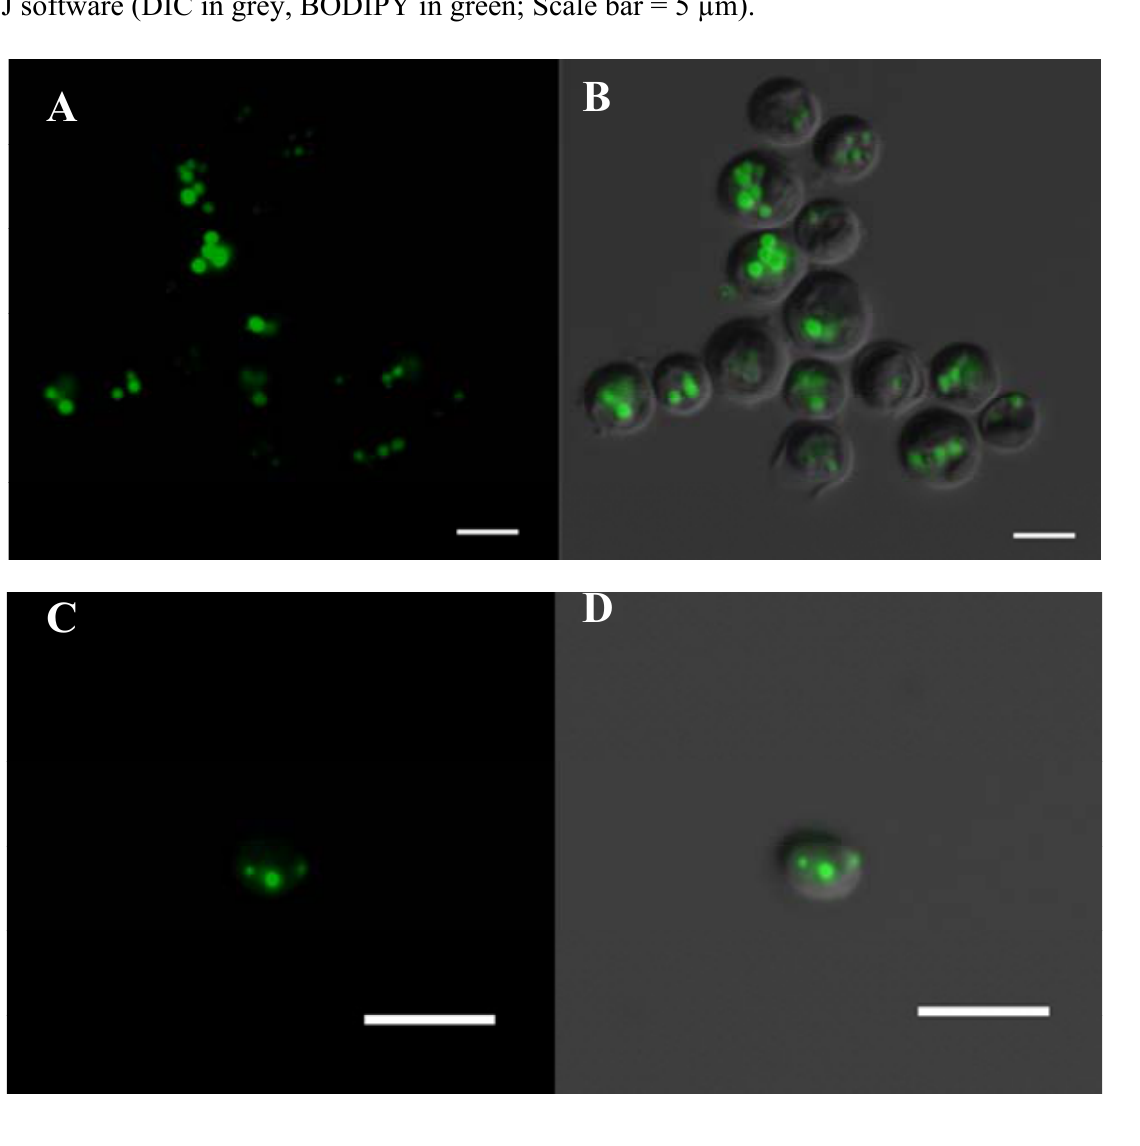
Figure 2. Desmochloris sp. SBL3 ( A and B ) and Picochlorum sp. SBL2 ( C and D ) internalized BODIPY dye in distinct lipid bodies. BODIPY dots could be observed with the FITC filter. Panels B and D were obtained by means of differential interference contrast (DIC). All images were acquired using the 100× objective and treated with Image J software (DIC in grey, BODIPY in green; Scale bar = 5